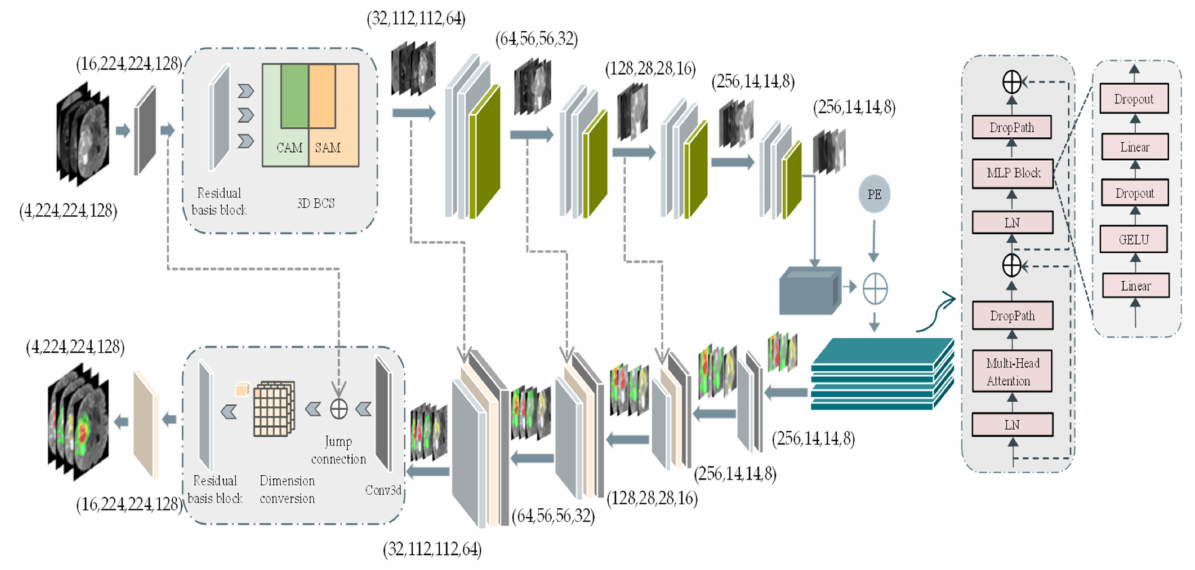
Figure 1. 3D BCS_T network model structure. The left side represents the encoder and decoder parts of the U-network, while the right side represents the self-encoder part of the Vision Transformer. Abbreviations: the channel attention module (CAM), the spatial attention module (SAM), positional encoding (PE). Furthermore, Conv3d represents a convolution operation with a convolution kernel size of 2 and a step size of